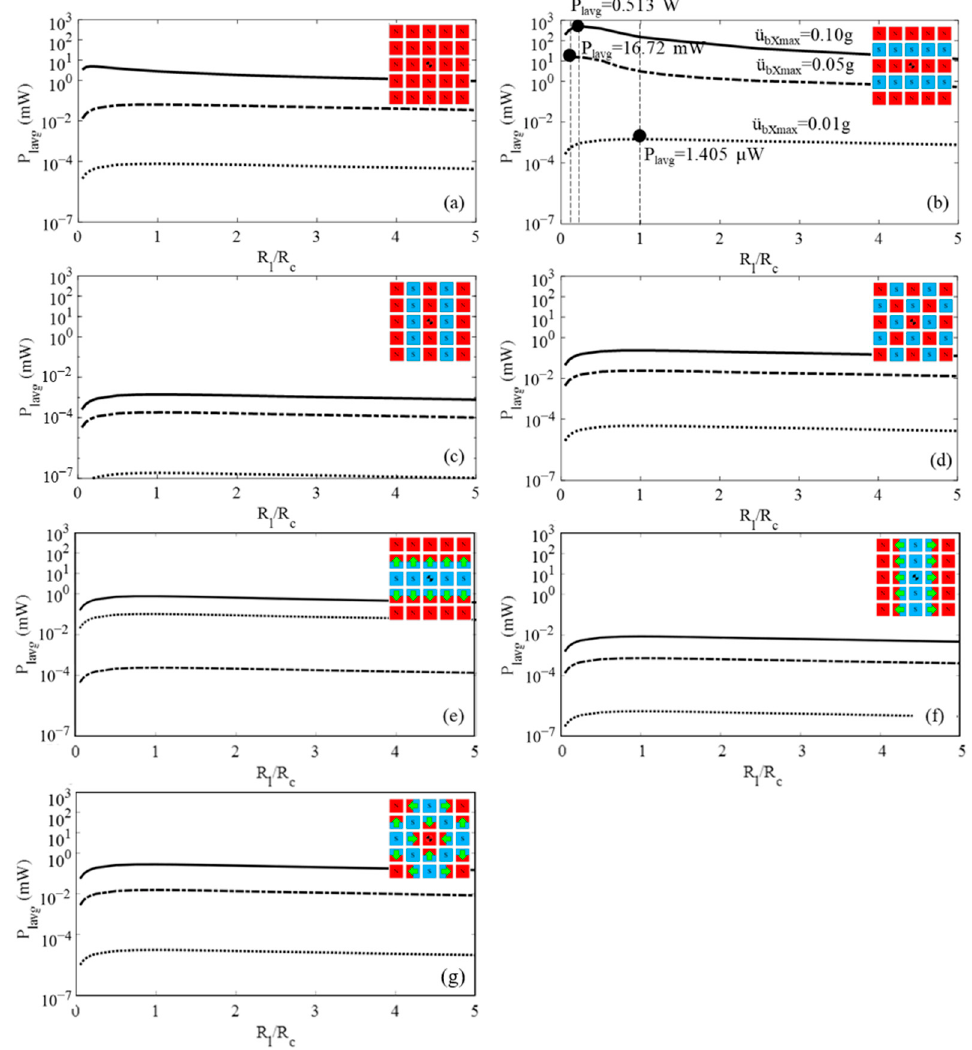
Figure 8. Average electrical power harvested from the EMEH versus the ratio of the load resistance to the coil resistance (R l /R c ) for ( a ) Array 1, ( b ) Array 2, ( c ) Array 3, ( d ) Array 4, ( e ) Array 5, ( f ) Array 6, and ( g ) Array 7.